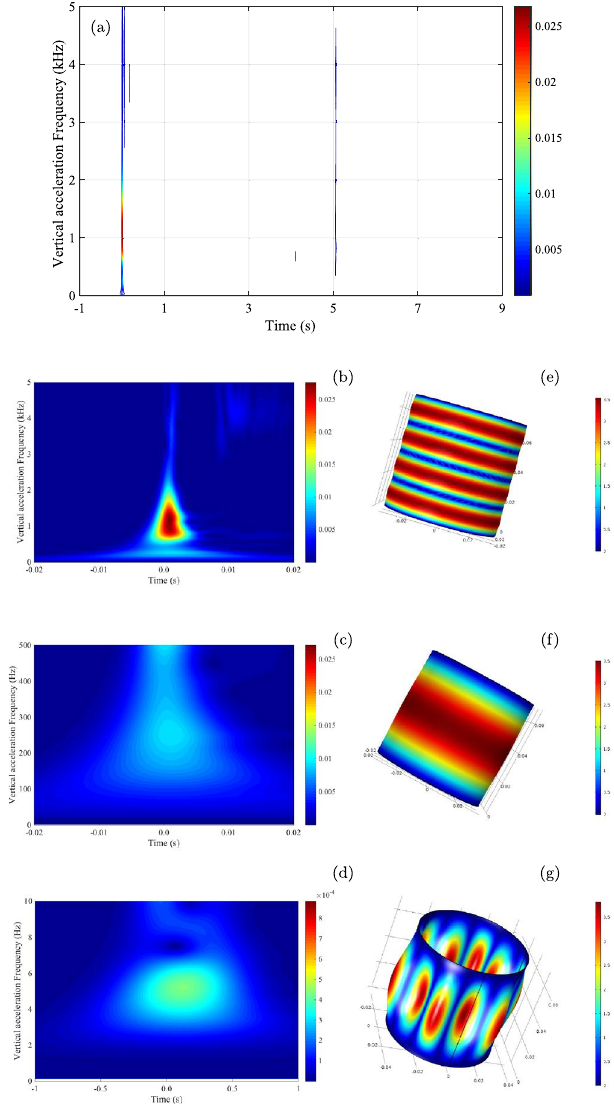
non-stationary signal of 10 s of vertical acceleration in isotropic liquefaction U 3 at 212 kPa (top). Details of spectrogram (left) and multiphysics numerical simulation 46 (right) on 1175 Hz (top), 253 Hz of solid isotropic linear elastic medium (middle), 5 Hz of thin latex membrane